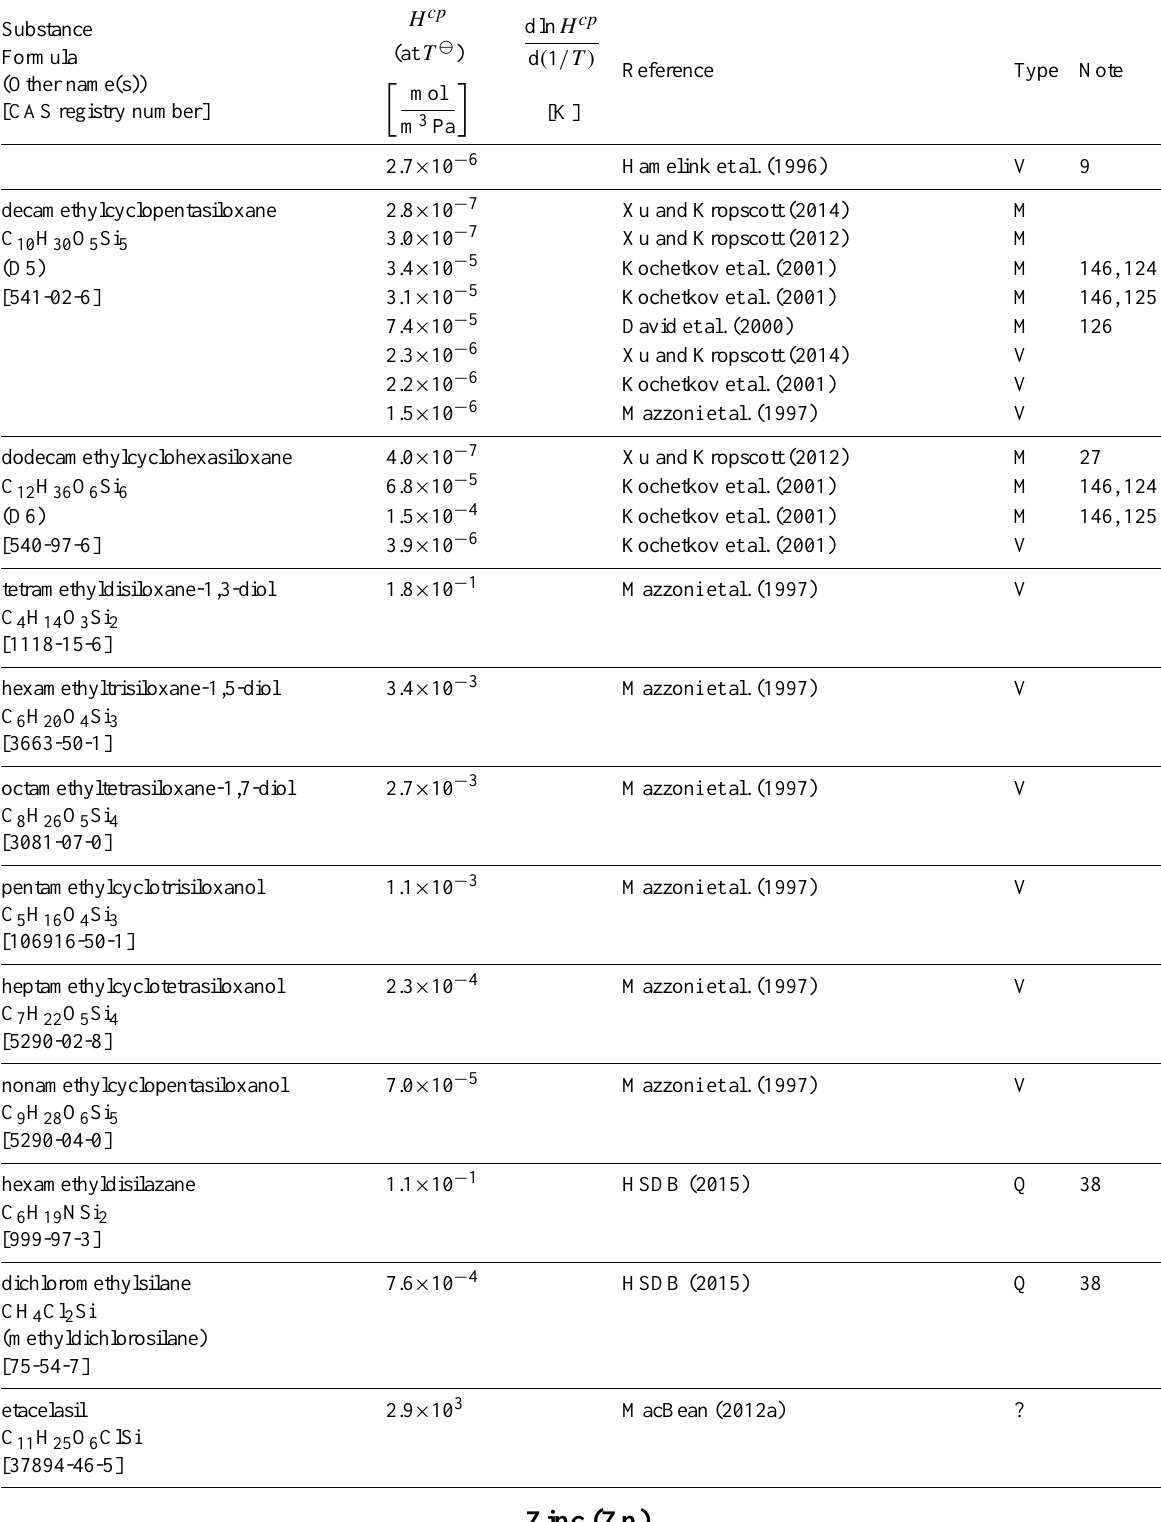
Table 6: Henry’s law constants for water as solvent